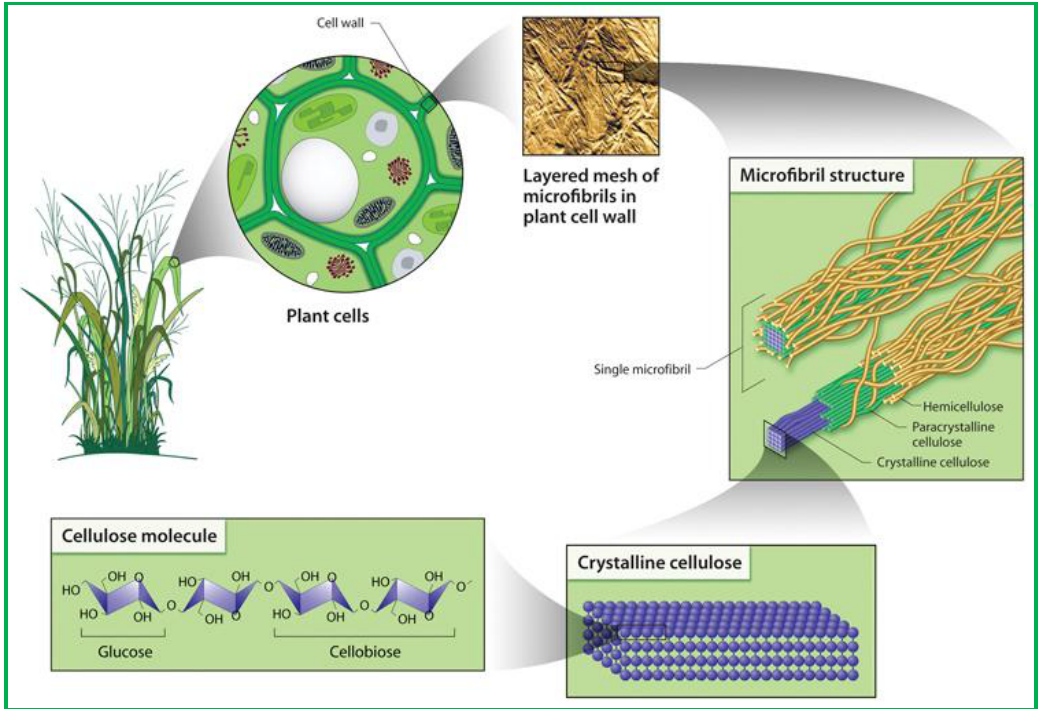
Figure 2. Scheme of the cellulose cell wall and microfibril organization